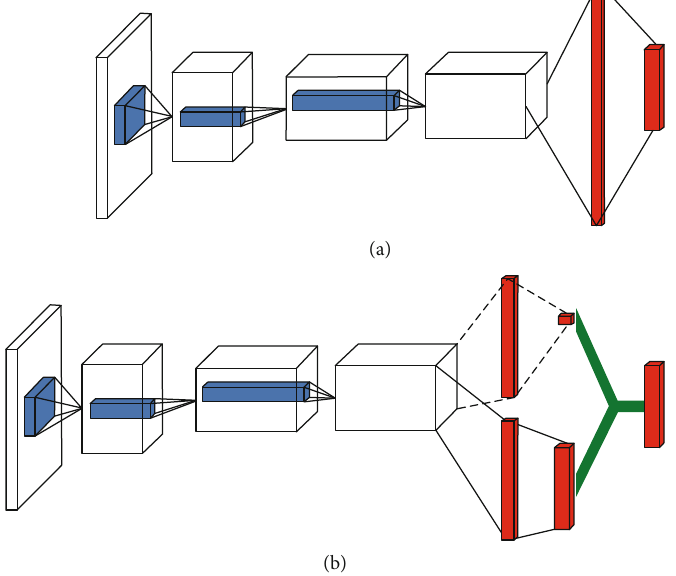
Figure 3: DQN and dueling Q-Network: (a) traditional DQN and (b) improved dueling Q-Network